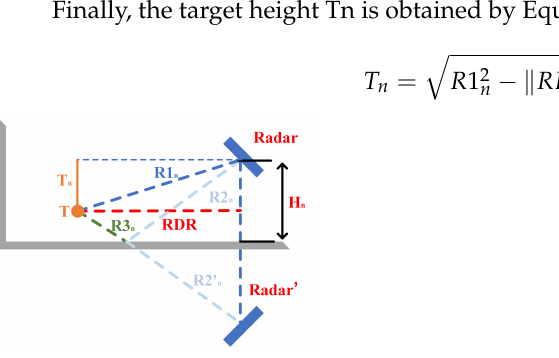
Figure 8. Obtaining the target